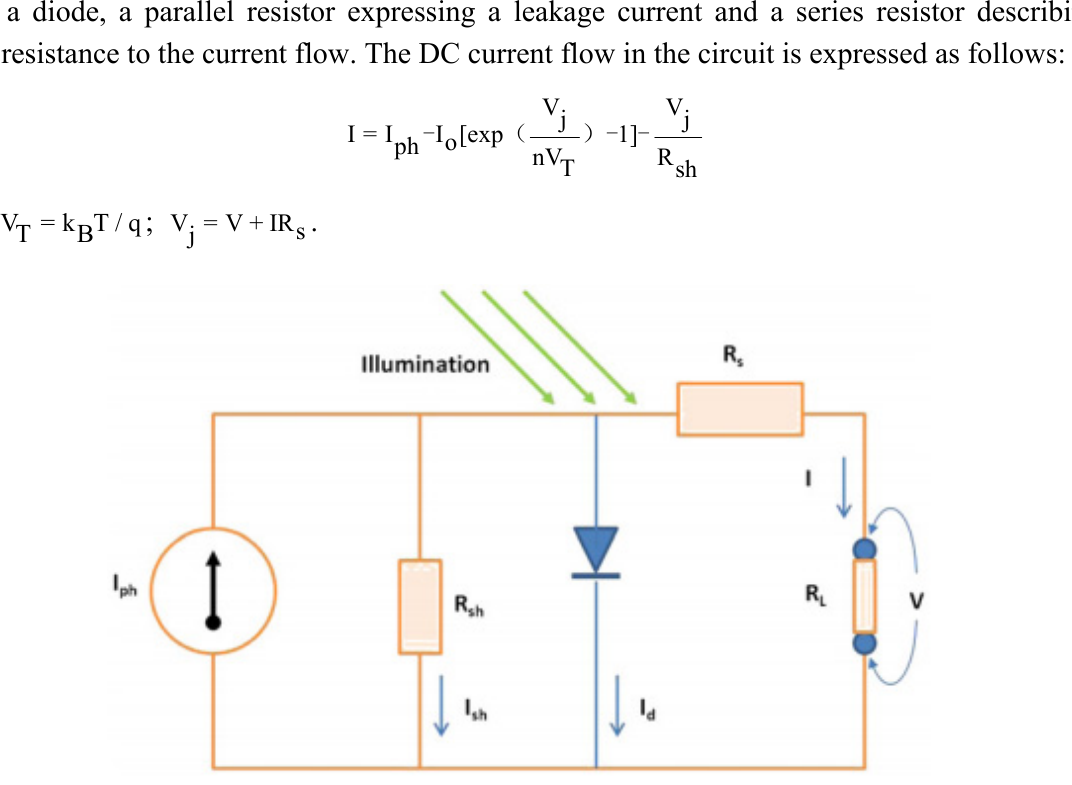
Figure 3. PV cell equivalent circuit model